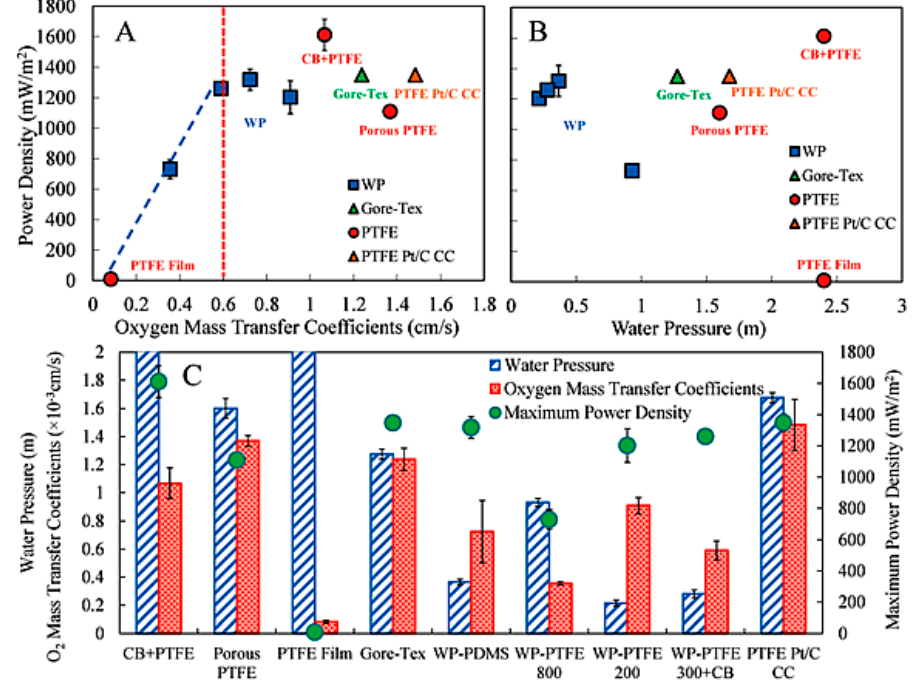
Figure 4. Maximum power density, oxygen diffusion coefficient, and water pressure of cathodes with different diffusion layers with the corresponding other characteristics. ( A ) Maximum power density vs. oxygen diffusion coefficient; ( B ) Maximum power density vs. water pressure; ( C ) Maximum power density, oxygen diffusion coefficient, and water pressure of cathodes with different diffusion layers. (Reproduced from [91] with permission of The Royal Society of Chemistry).